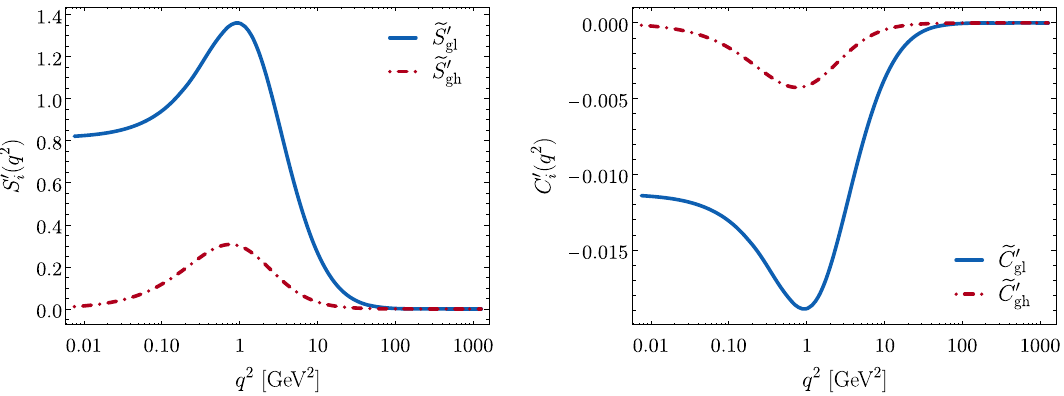
Fig. 7 Unnormalized gluon and ghost solutions (cid:2) S (cid:4)